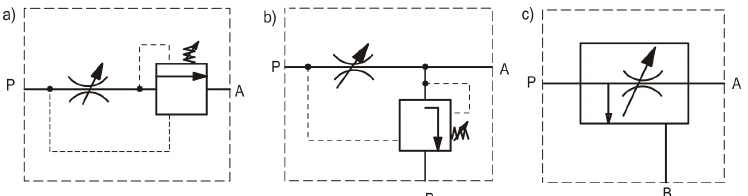
Figure 1. Drawing symbol of a flow regulator; ( a ) valves connected in series, ( b ) valves parallel connected, ( c ) simplified; P, A, B—connection